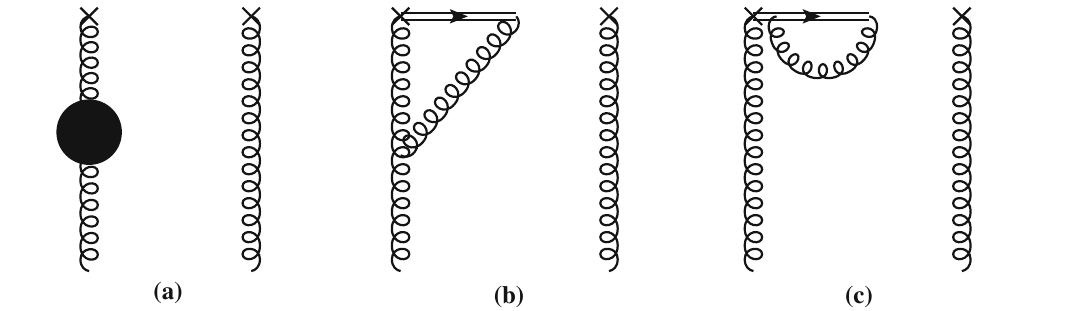
Fig. 3 One-loop virtual corrections to quasi (light-cone) gluon distribution in Feynman gauge, the conjugate diagrams are not shown. The double line includes both the gauge link and non-abelian